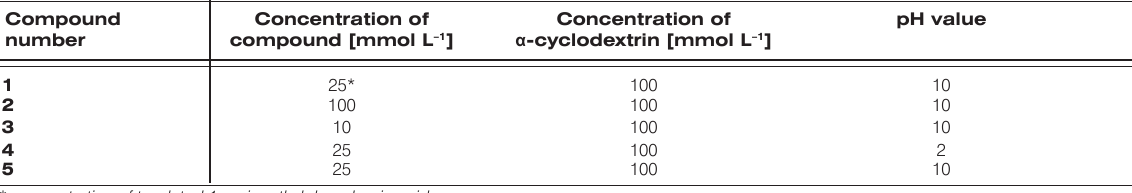
Table 2. Optimal enantiomer separation